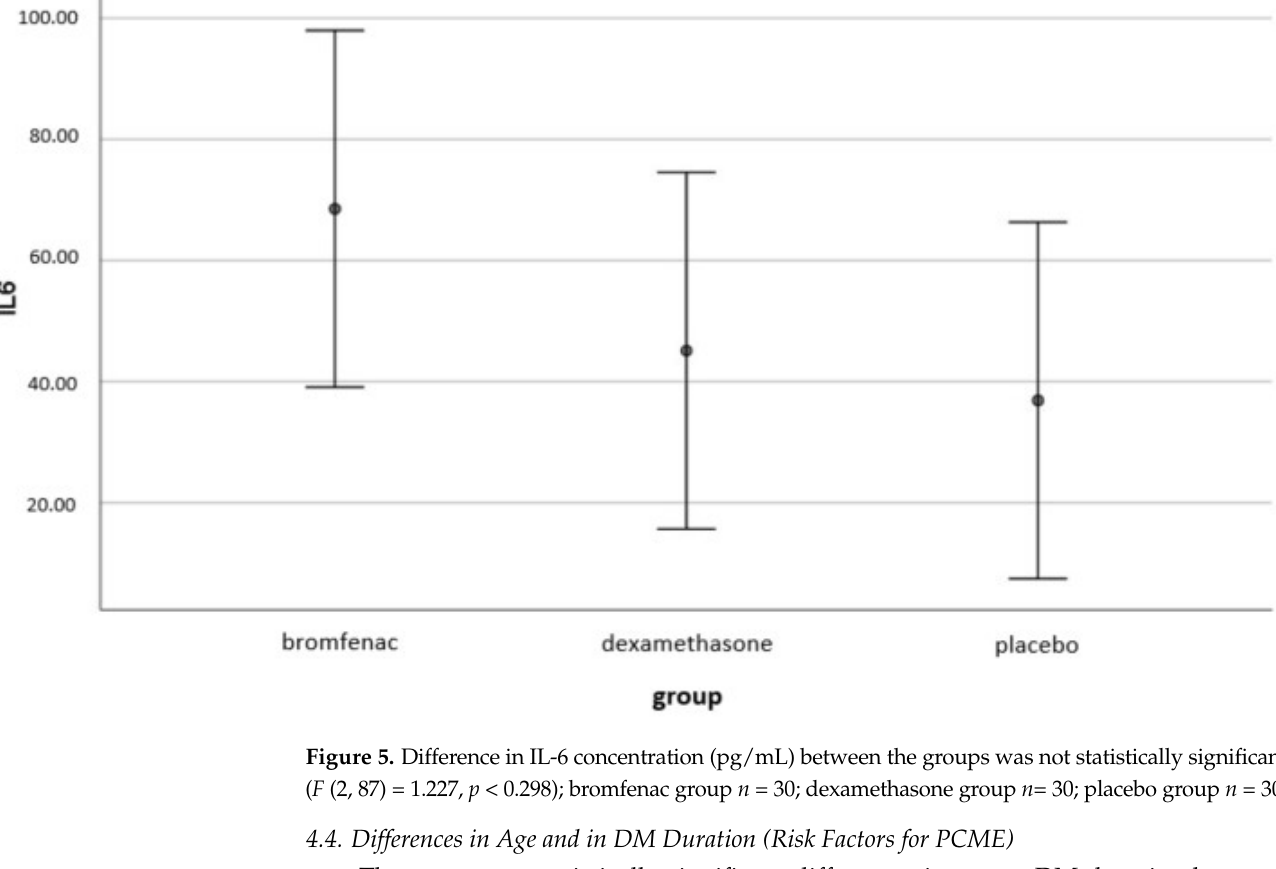
three groups with respect to intraocular IL-6 concentration ( F (2, 87) = 1.227, p < 0.298). (Figure 5).